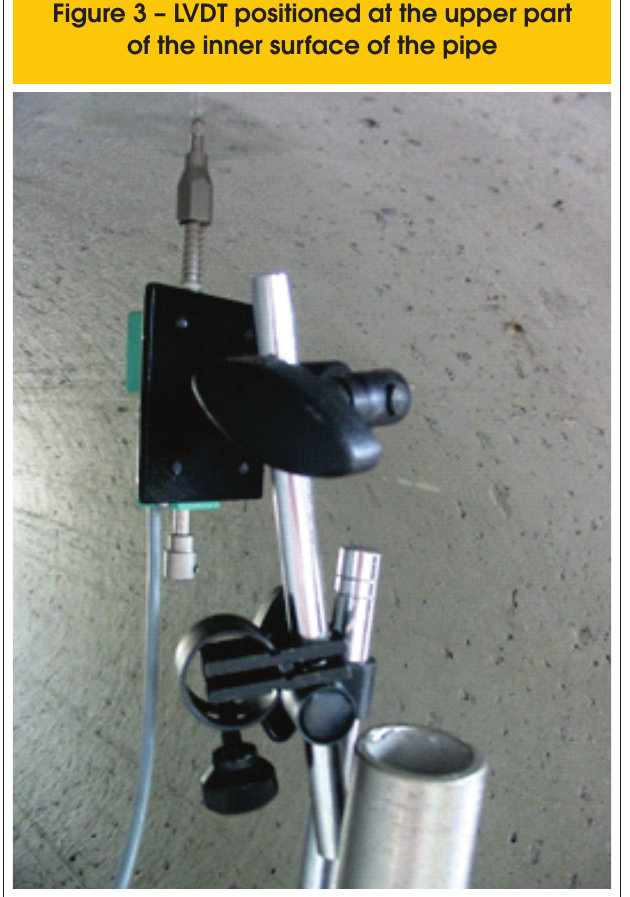
Figure 3 – LVDT positioned at the upper part of the inner surface of the